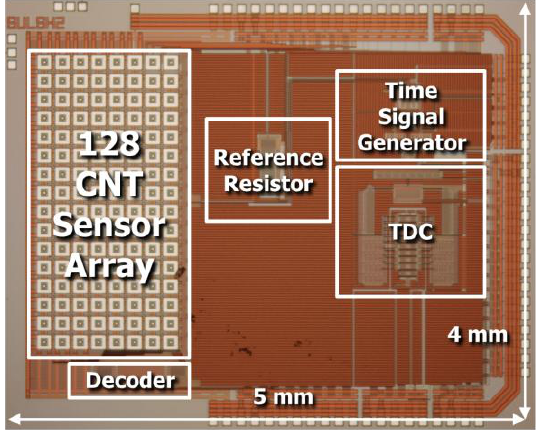
Figure 3. Optical image of the CNT ROIC die.